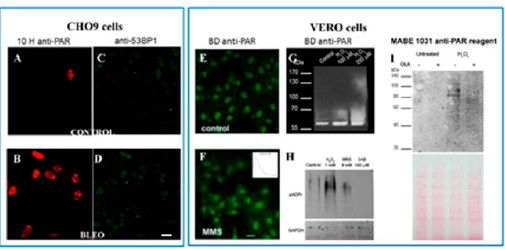
Figure A4. Positive controls for anti-PAR antibodies. ( A – D ) Comparison of the control ( A , C ) and BLEO-treated cells ( B , D ; 40 µg/mL, 45 min, like VERO) that were indirectly immunostained with 10H anti-PAR ( A , B , red) and anti-53BP1 ( C , D , green) Bar: 15 µm. PAR-positive nuclei were much more frequent in CHO9 than in VERO cells. ( E , F ) ICF with BD anti-PAR antibody (same experiment as in Figure 3G, H, extracted from Ph.D. thesis [53] Bar: 25 µm). Only after a very strong treatment with MMS ( F ; 6 mM, 45 min), which induced cell death of the whole cell population (insert), was a slight PAR increase noticed with BD anti-PAR. ( G ) WB detecting PAR with BD anti-PAR in control cells or cells exposed to 100 and 250 µ M H 2 O 2 . ( H ) WB detecting PAR indirectly with the rabbit PAR-binding reagent MABE1031 (1:4000) and anti-rabbit-HRP in control VERO cells or under exposure to 1 mM H 2 O 2 (10 min), 8 mM MMS (45 min), or the PARP inhibitor 3AB (2 h). ( I ) WB detecting PAR with MABE1031 in the control VERO cells or under exposure to OLA (1 h), H 2 O 2 (last 10 min), or the combined treatment OLA + H 2 O 2